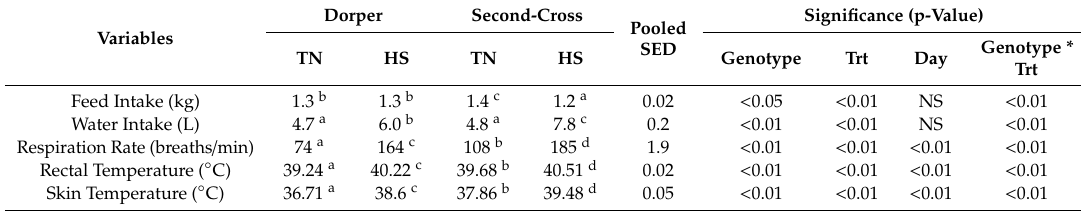
Table 2. Mean ( ± SED) physiological parameters in Dorper and SC (pooled across the experimental period of 14 days) lambs subjected to either TN or HS conditions ( n = 12 /